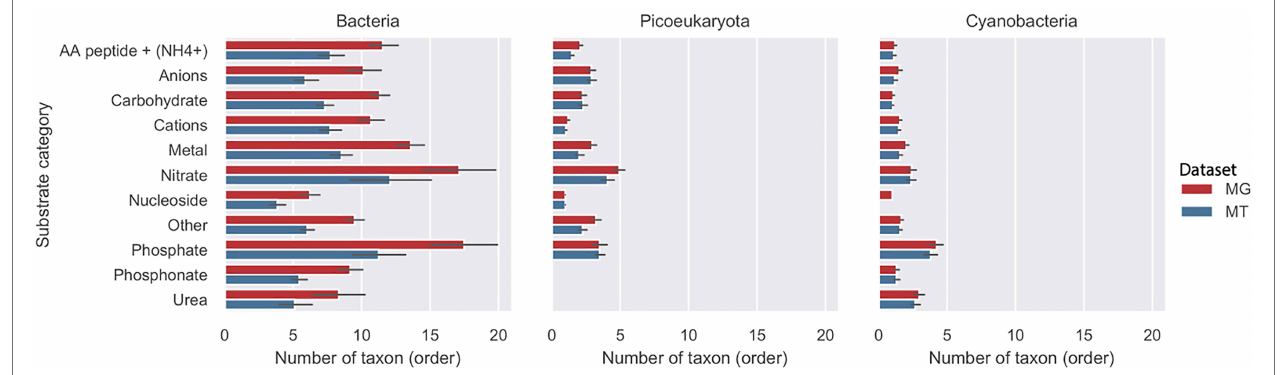
FIGURE 4 | Diversity of transporters in three taxonomic groups during the 2012 growth period (10 months). Number of taxa (order) at rank order shown per putative substrate category for bacteria, picoeucaryotes, and cyanobacteria in the LMO metagenome (MG) shown with red bars and metatranscriptome (MT) shown with blue bars.